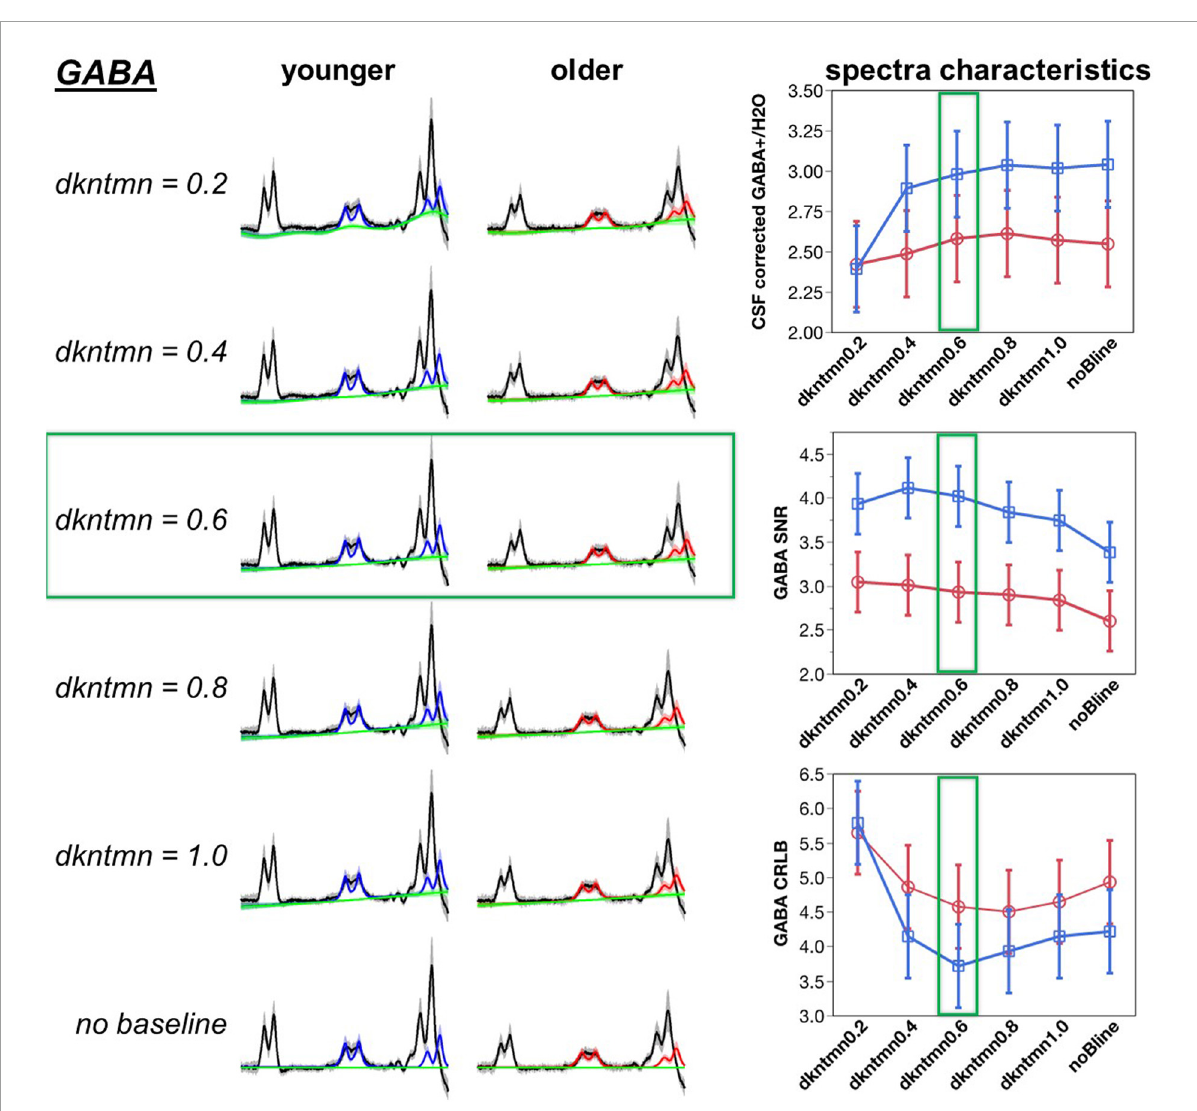
FIGURE3 Optimization of difference signal baseline fitting for GABA. A lower dkntmn indicates a more flexible baseline and higher dkntmn indicates a stiffer baseline. Fitting results for the GABA+ moiety for dkntmn 0.2–1.0 ppm and no baseline are shown for younger and older cohorts. Black line = average raw spectra, blue = GABA fit for younger, red = GABA fit for older, green line =